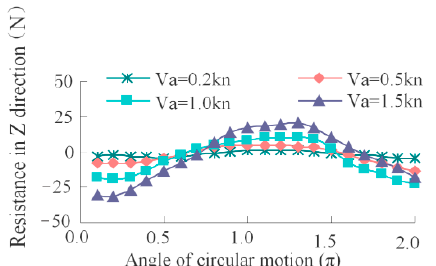
Figure 18. Z-directional fluid resistance of the underwater robot.